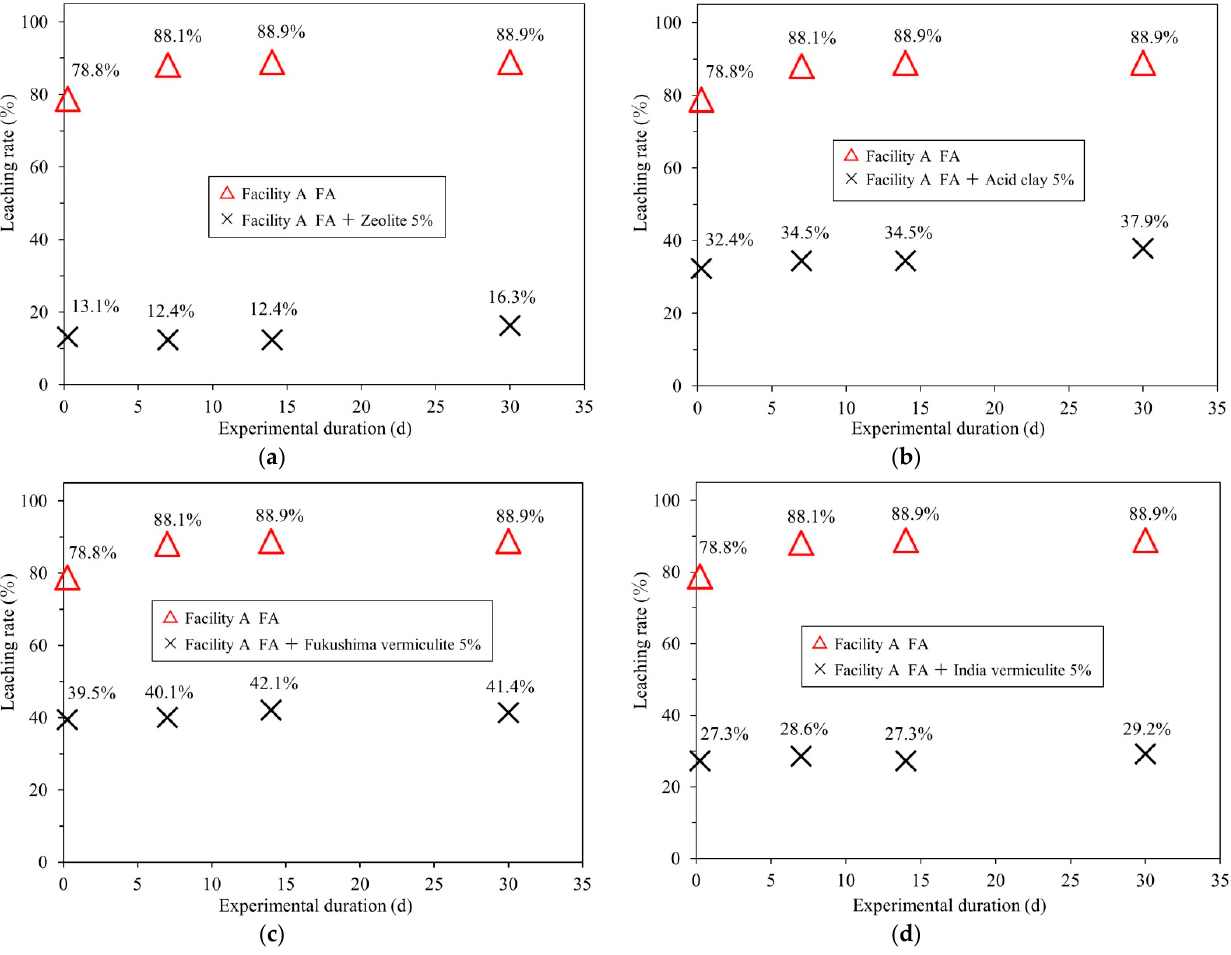
Figure 6. Changes in radioactive cesium leaching rate with respect to time (fly ash, FA): ( a ) Zeolite; ( b ) Acid clay; ( c ) Fukushima vermiculite; ( d ) India vermiculite.